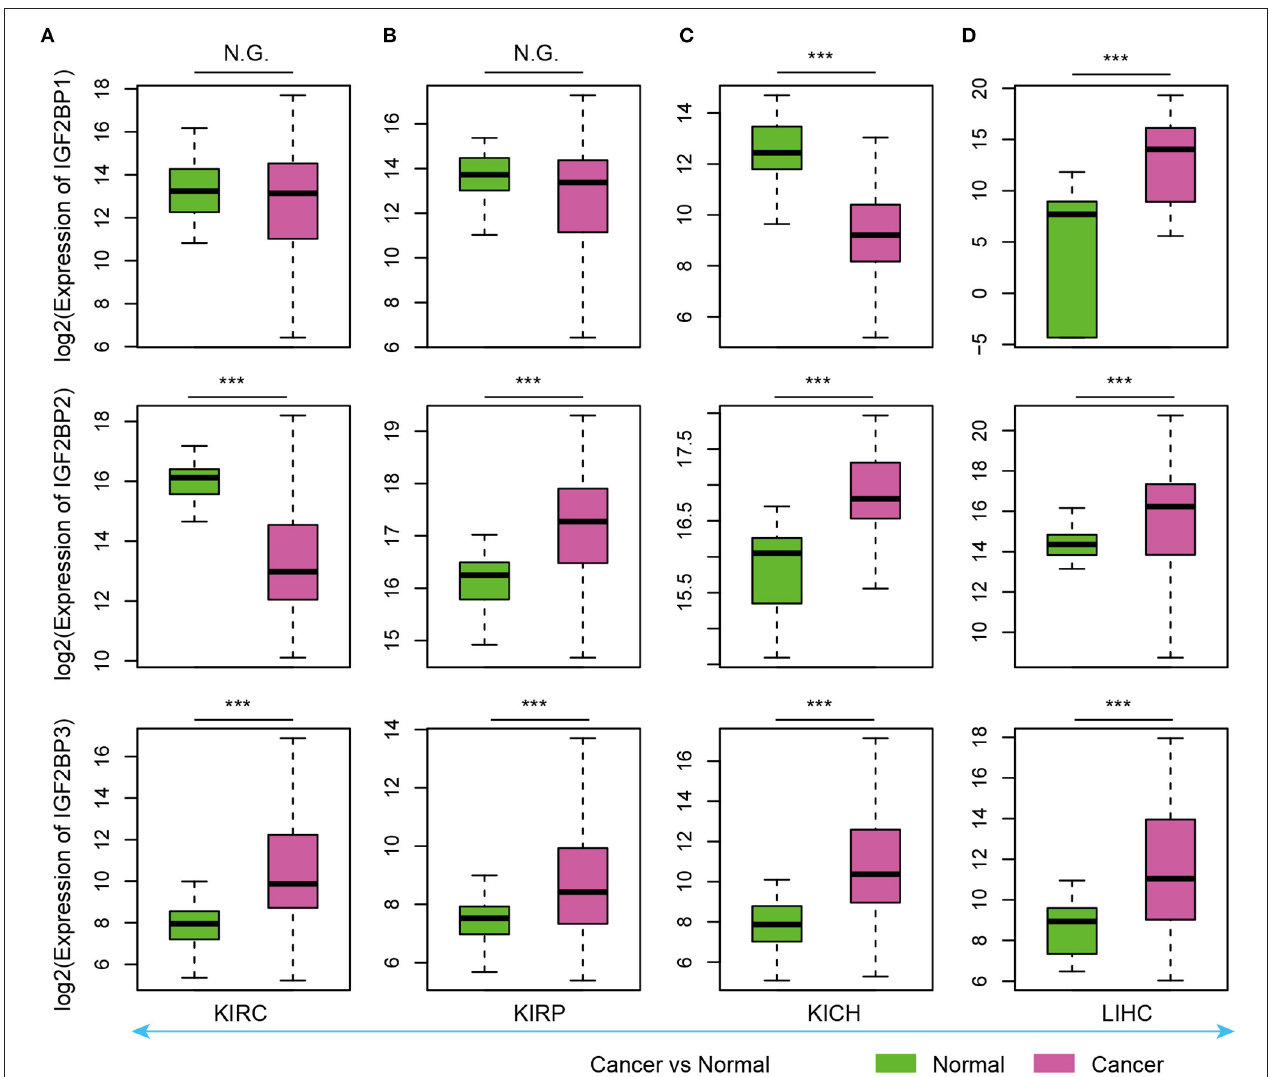
FIGURE 3 | Box plots showing the expression of IGF2BP1/2/3 in cancer and normal samples. (A) Expression of IGF2BPs in KIRC. (B) Expression of IGF2BPs in KIRP. (C) Expression of IGF2BPs in KICH. (D) Expression of IGF2BPs in LIHC. *** P < 0.001 for Wilcoxon rank sum test. N.G. indicates not significant.